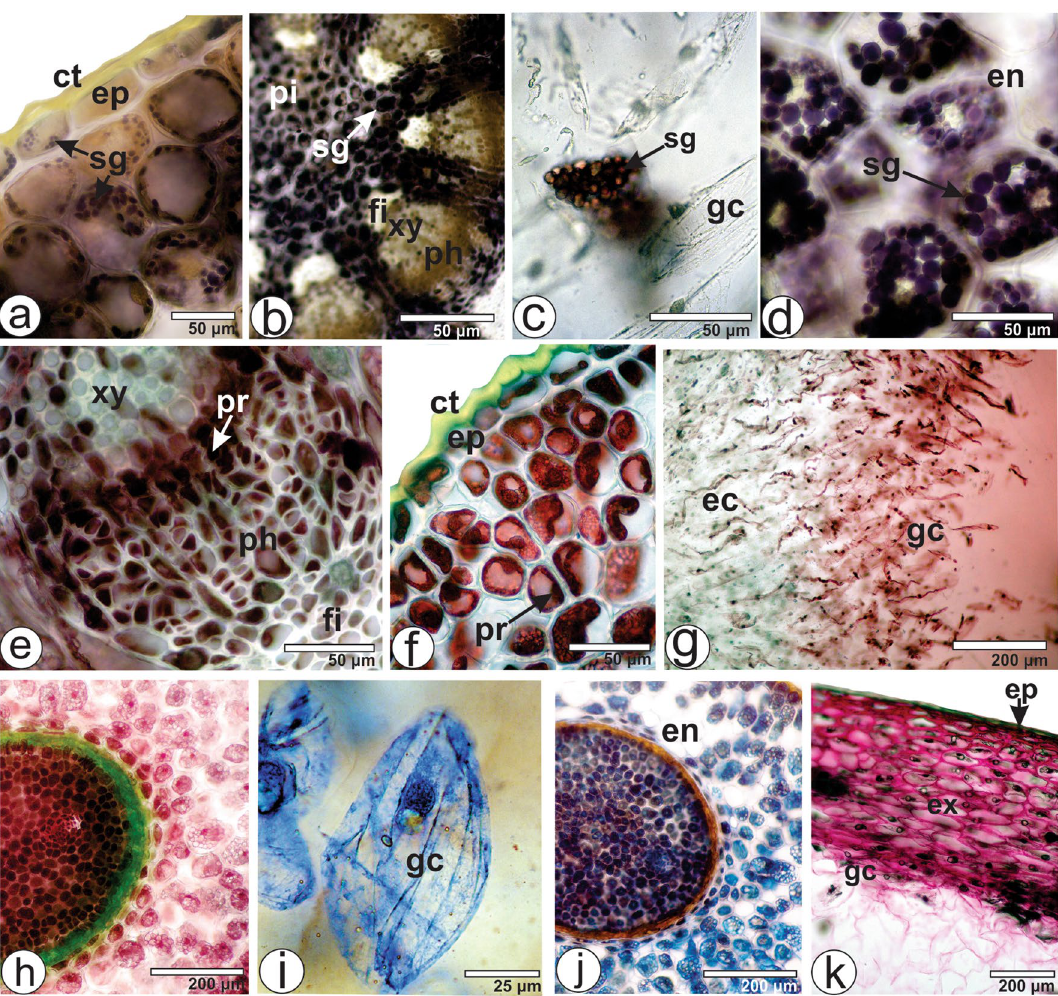
Figure 7. Microchemical tests of Viscum album subsp. album (Cross-sections of ( a ) Lamina, ( e ) Midrib, ( b , f ) Stem, ( c , g , i ) Berry, and ( d , j , k ) Seed. Reagents: ( a - d ) Iodine solution. ( e – h ) Xylidine Ponceau. ( i , j ) Coomassie Brilliant blue. ( k ) Ruthenium red. ct cuticle, ec palisade-like elongated cells with spirally thickened walls, en endosperm, ep epidermis, ex exocarp, fi fiber, gc globular cells, ph phloem, pi pith, pr protein, sg starch grain, xy